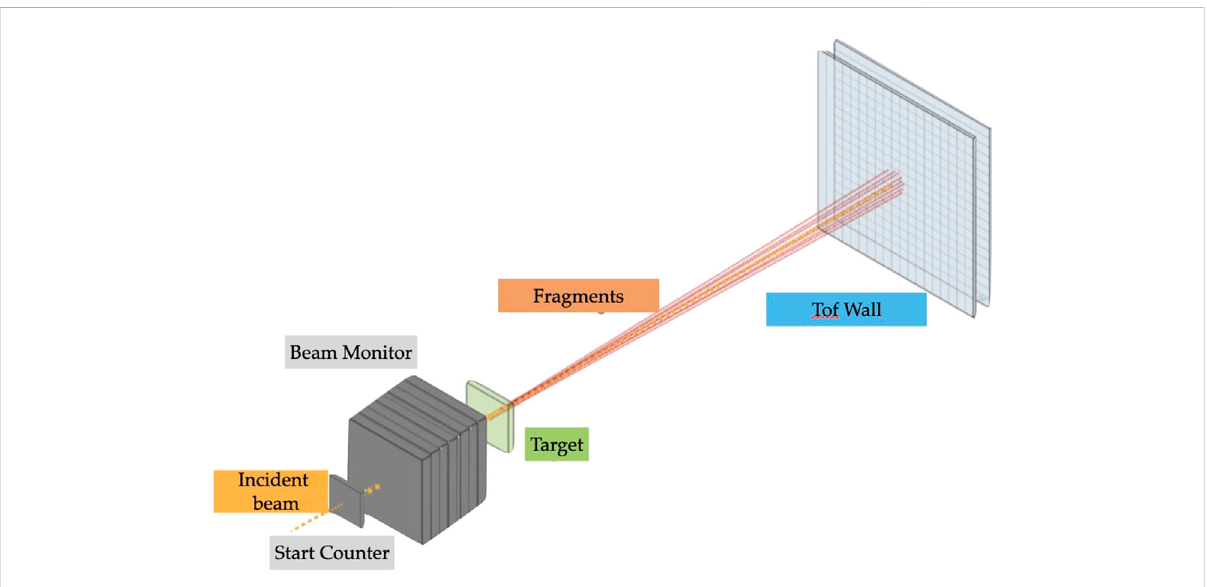
FIGURE 1 Schematic view of the GSI experimental setup. The 16 O beam passes upstream of the target through the Start Counter and the Beam Monitor. Afterimpingingonthe5 mmthickgraphiteslab,theproducedparticlescanbeidenti fi edbytheTof-Walldetector,about180 cmdownstreamofthe